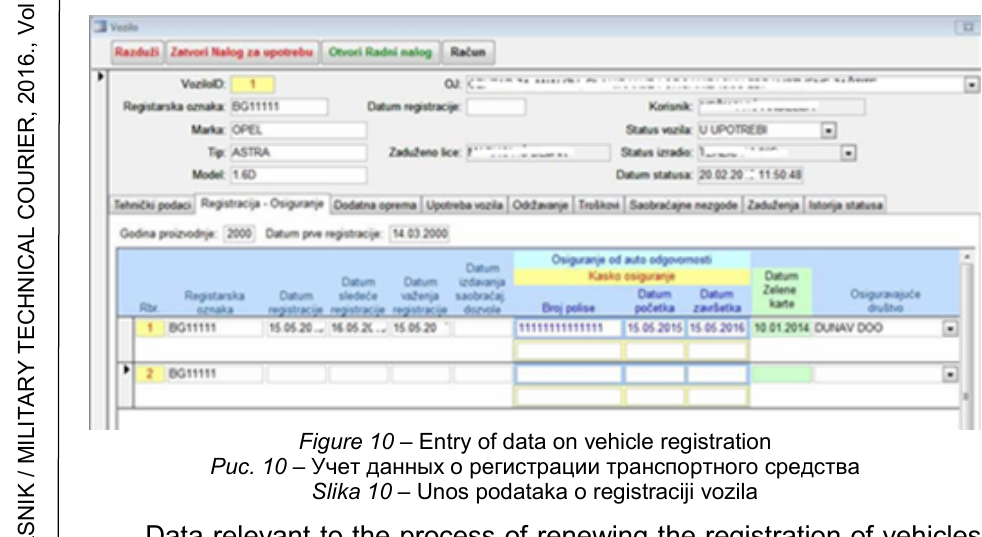
Figure 10 – Entry of data on vehicle registration